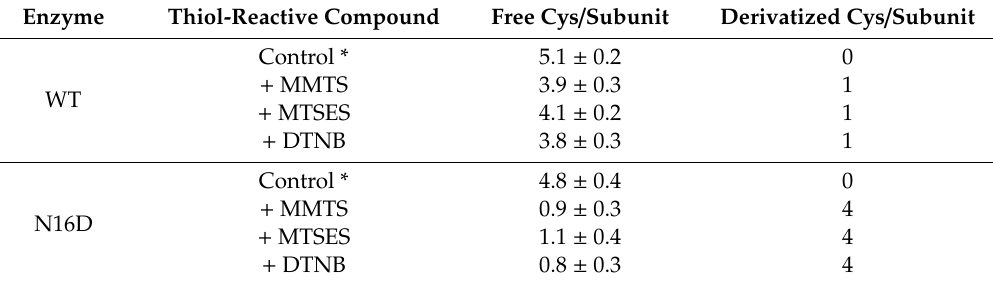
Table 1. Cys quantification in the WT and N16D HsTIM enzymes.